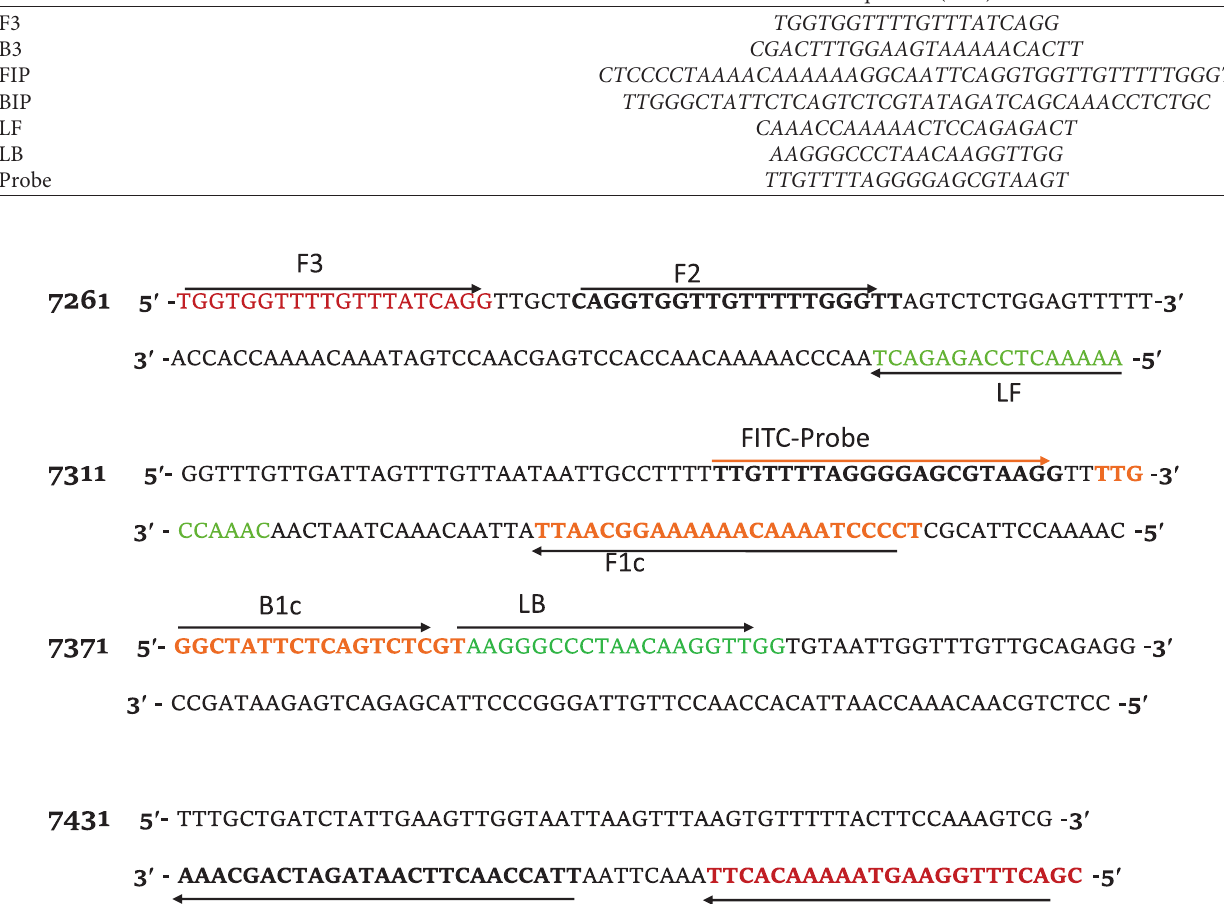
Figure 1: Nucleotide sequence of the NADH-1 gene sequence of E. granulosus (GenBank accession number MG672292) used to construct (indicated in bold and color) the outer (F3/B3), inner (FIP/BIP), and loop (LF/LB) primers and probe. The inner primers FIP and BIP comprise the complementary sequences to F1c and B1c, and F2 and